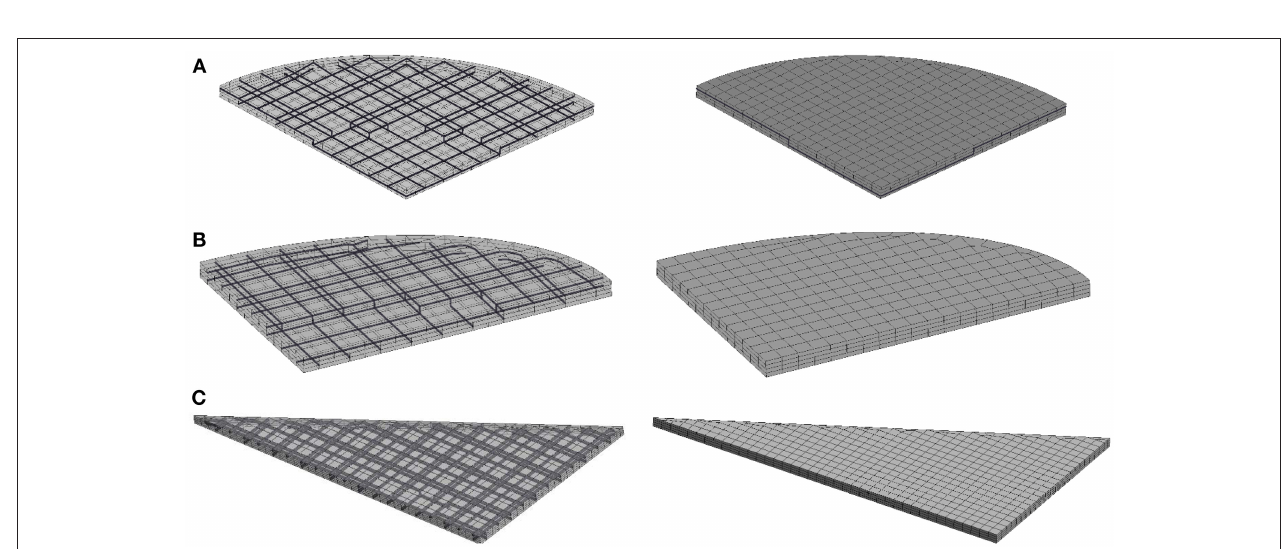
FIGURE 9 | Finite element meshing of steel reinforcement and plain concrete of: (A) circular slab, (B) elliptic slab, and (C) triangular slab.